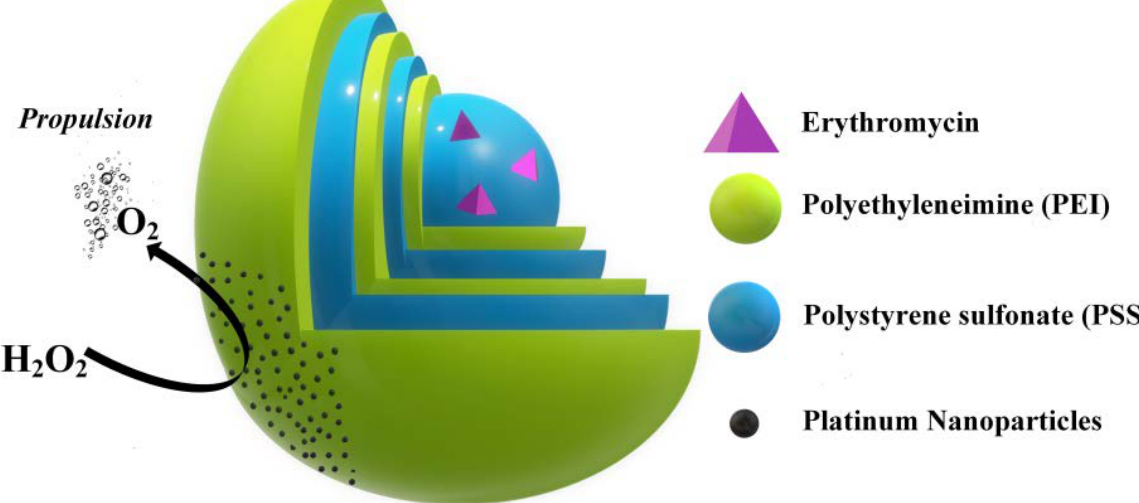
Figure 13. Schematic representation of ERY Janus micromotors. Adaptation from Figure 13 . Schematic representation of ERY Janus micromotors. Adaptation from [103].